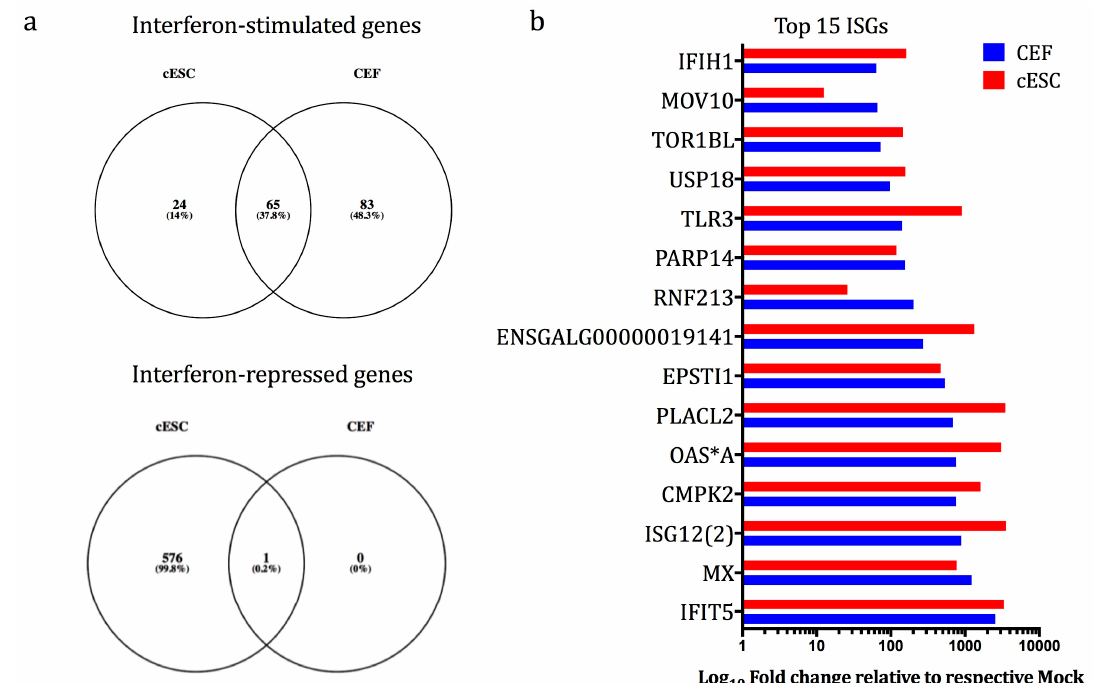
Figure 4. ( a ) Venn diagrams showing the distribution of unique and shared up- and down-regulated transcripts in interferon (chIFN- α )-stimulated CEF and cESC. The numbers in the intersections of each circle represents the number of transcripts common to each condition (FDR ≤ 0.05 and fold change ≥ ±3.0). ( b ) Differential expression (log 10 fold-change related to respective mock samples) of the top 15 ISGs (fold change ≥ |±3.0| and FDR ≤ 0.05) as identified in cESC and CEFs [25] following chIFN- α stimulation (Supplementary file 1).